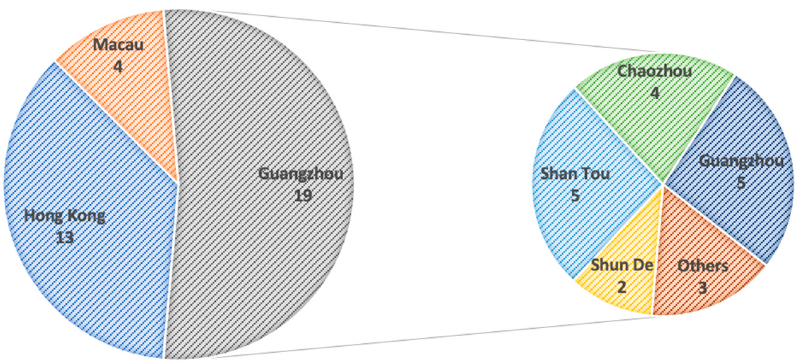
Figure 1. Residential districts of students in